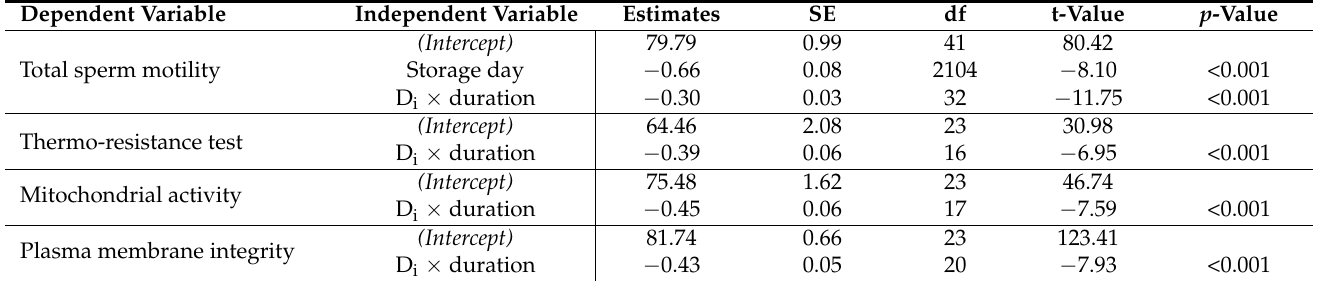
Table 3. The results of the regression analysis are shown, explaining the impact of vibrations on sperm quality characteristics during transport. The linear mixed model includes the interaction of vibration intensity (D i ) and duration of simulation as fixed effects and the boar as a random effect on intercept and slope. In addition, the storage days (d1–4) were considered for total sperm